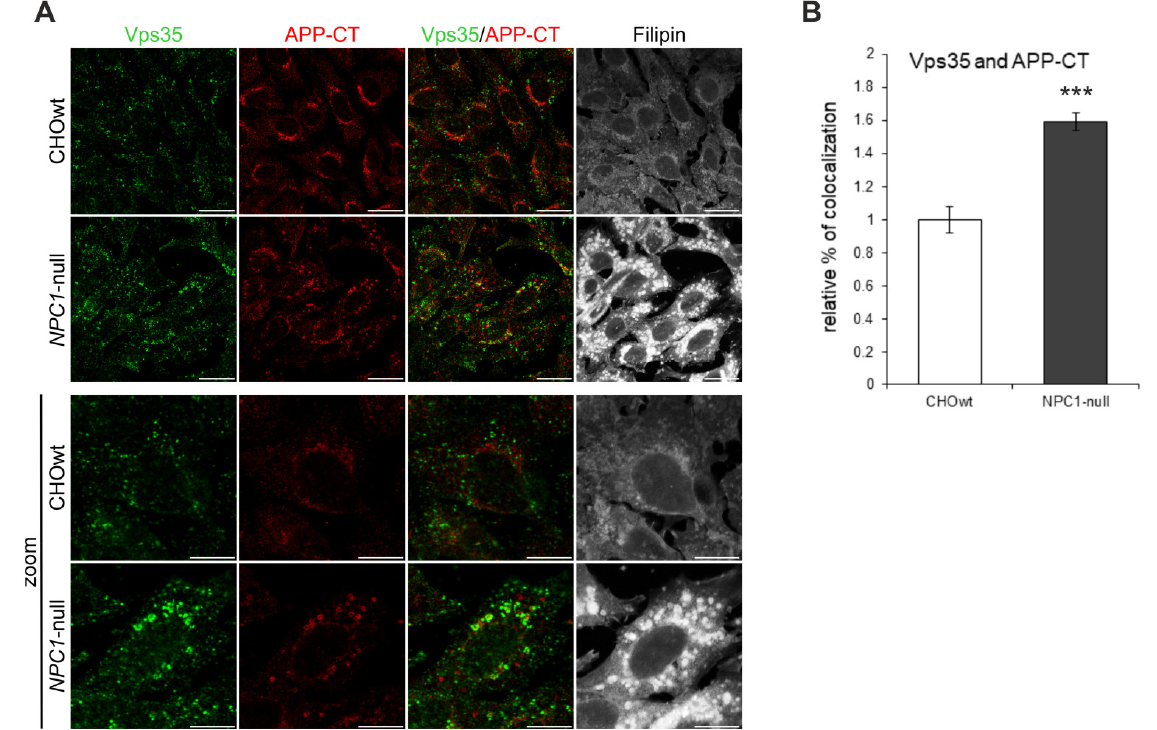
Figure 3. Colocalization of Vps35-positive vesicles and APP-CT is increased in NPC1 -null cells. ( A ) The cells were grown in 10% FBS in DMEM/F12 media, fixed and stained for Vps35 (green) and C-terminal APP antibody (APP-CT), which detects full-length-APP and the membrane-bound C-terminal APP fragments. Filipin was used for the staining of free cholesterol. Cells were analyzed by confocal microscopy, and fluorescent signals were quantified using ImageJ software. ( B ) Colocalization of Vps35 and APP-CT was compared between CHOwt and NPC1 -null cells, *** p < 0.001. The data are shown as mean ± SD normalized to control, n = 30 cells per group from three different experiments. Scale bar—20 µ m (unzoomed figures) and 10 µm (zoomed figures).